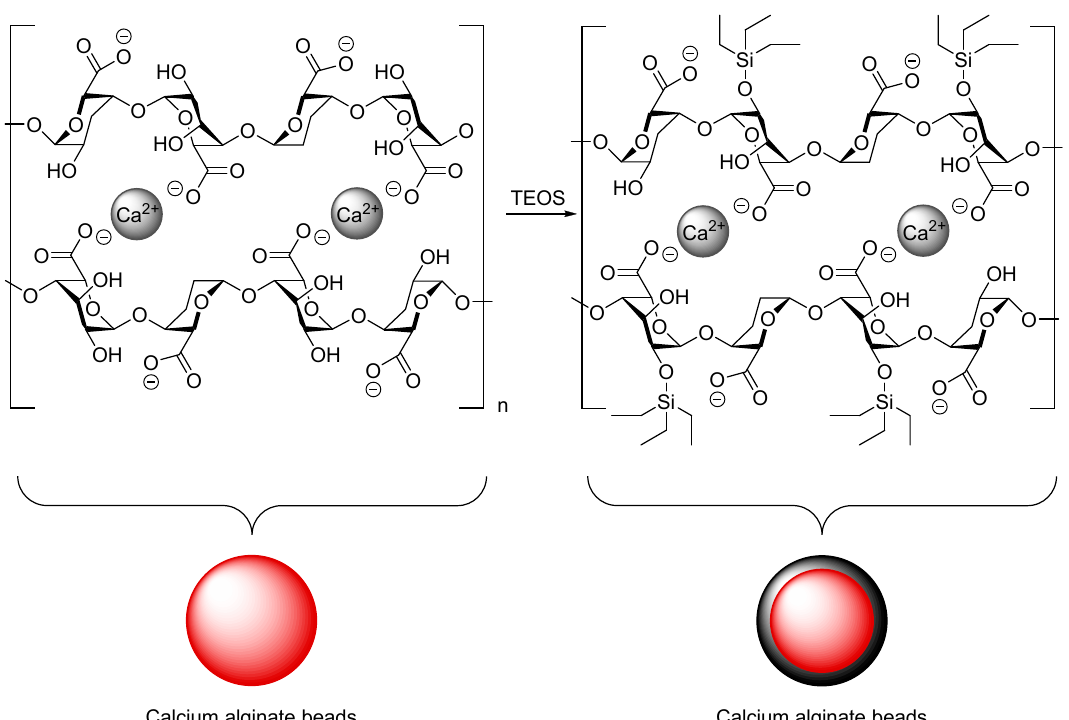
Scheme 4. Silica-coating of calcium alginate beads using TEOS.